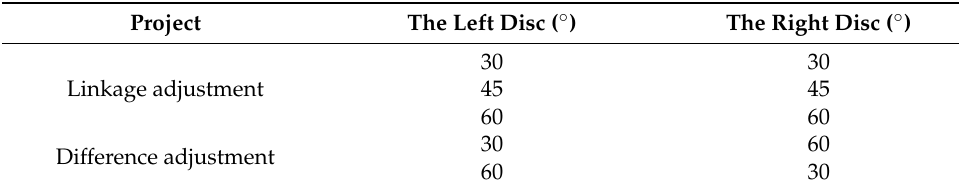
Table 1. Method for adjusting the angle of covered soil disc.